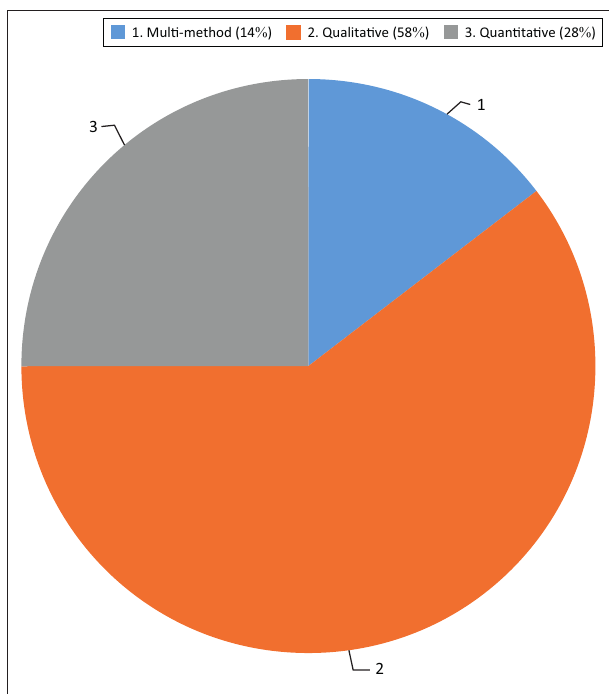
FIGURE 4: Articles by